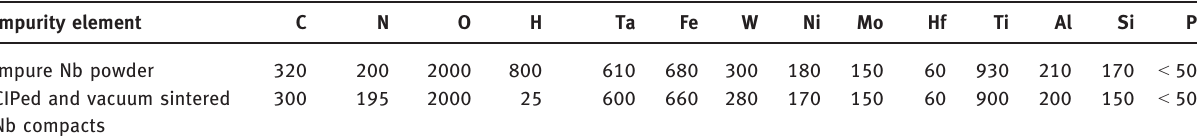
Table 3: Chemical analysis of impure Nb powder, CIPed and vacuum sintered Nb compacts and 80 mm diameter EB melted Nb ingot produced at different melt